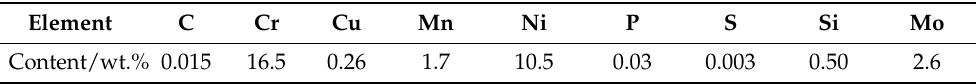
Table 1. Chemical composition of the AISI 316L tube material (wt.%, balance Fe).